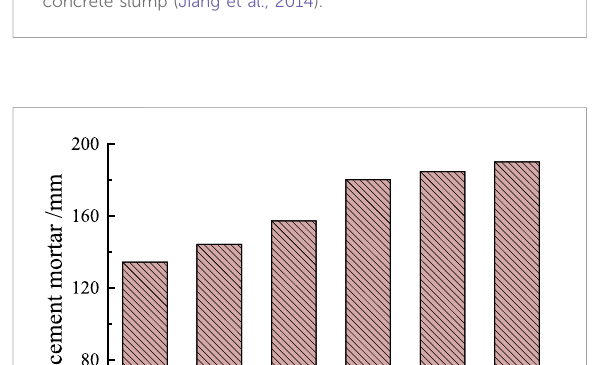
FIGURE 2 In fl uence of basalt fi ber length and volume content on concrete slump (Jiang et al., 2014).